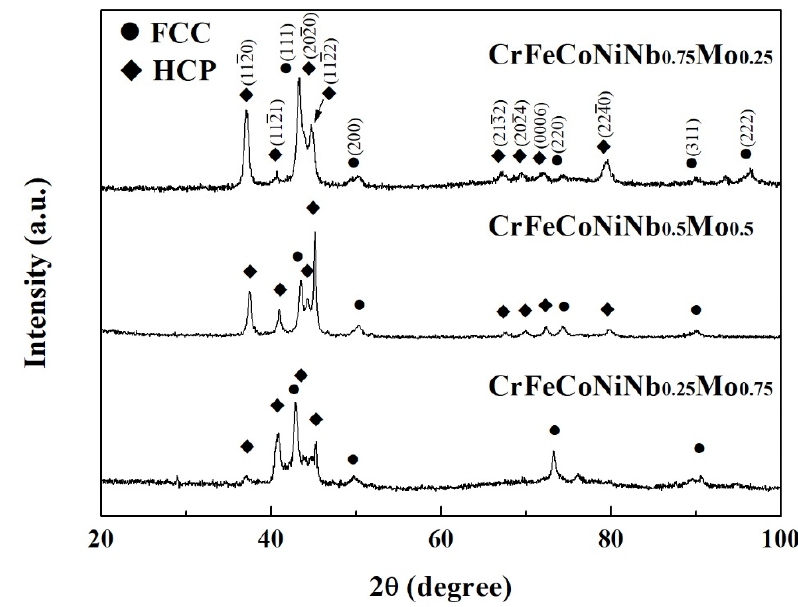
Figure 7. XRD patterns of as-cast CrFeCoNiNb x Mo 1 − x alloys.